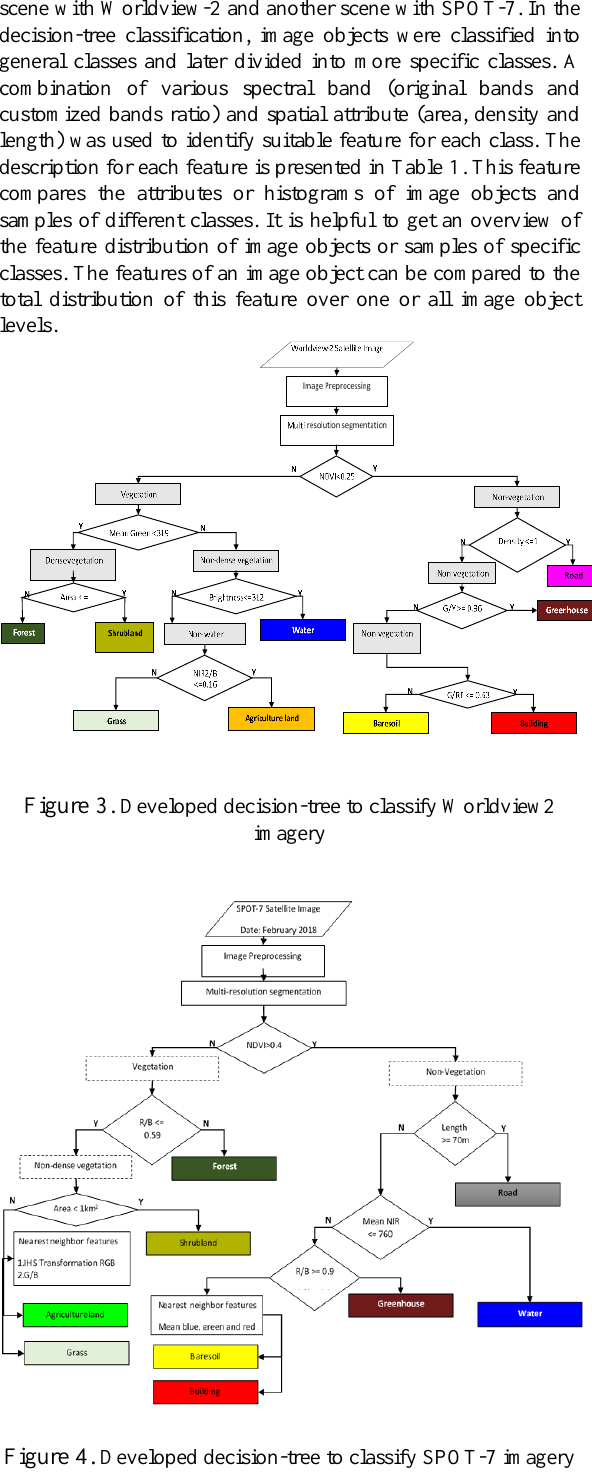
Figure 4. Developed decision-tree to classify SPOT-7 imagery